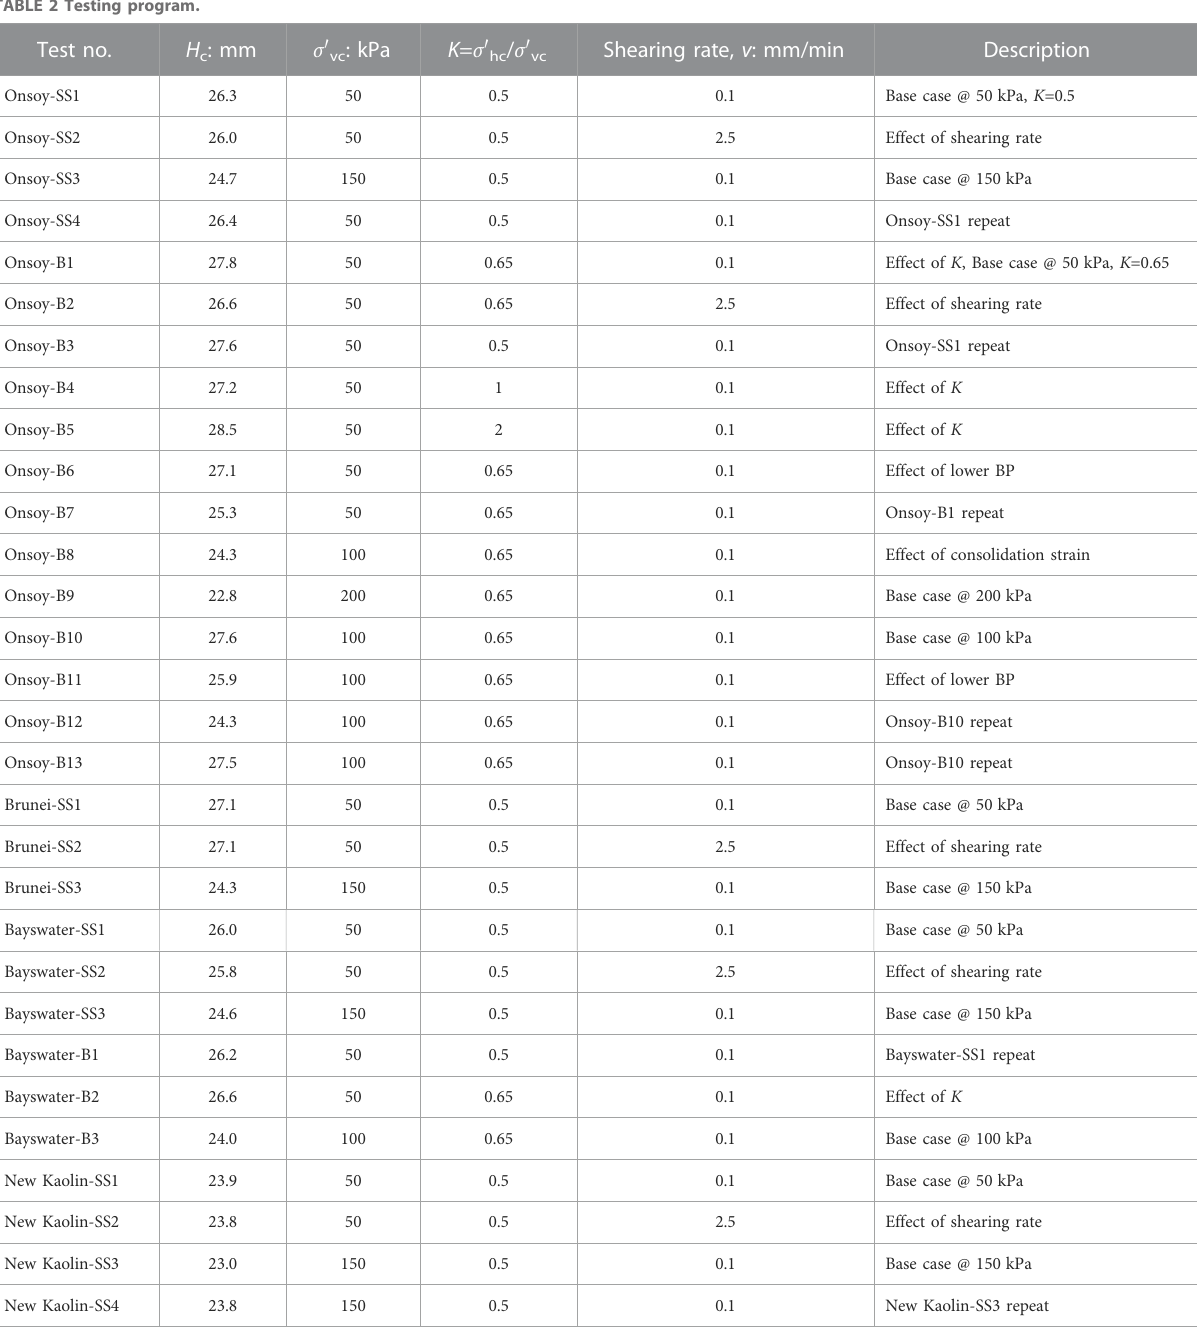
TABLE 2 Testing